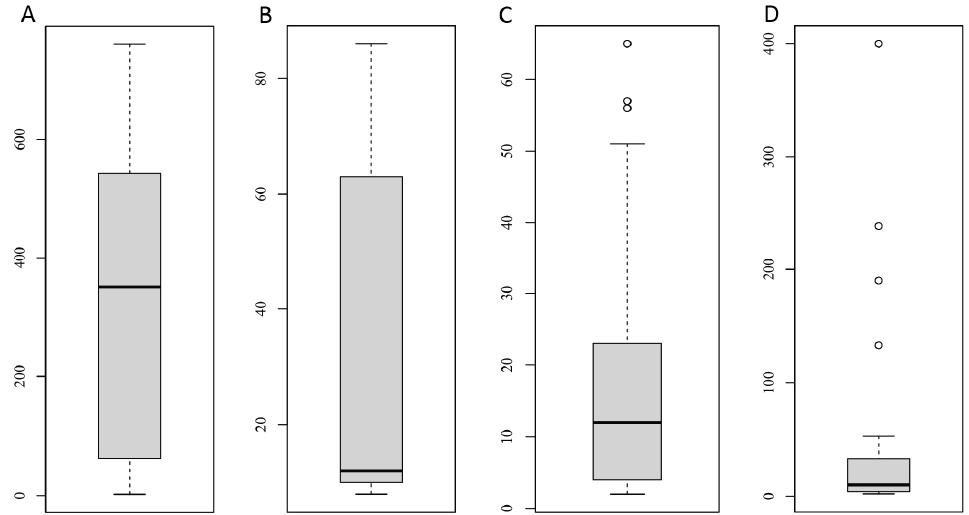
Figure 4. Egg count per gram of the observed helminth taxa in all samples. ( A ) Acanthocephala; ( B ) Capillariidae; ( C ) Trichostrongylidae; ( D ) Spiruroidea. Table 6. Details of the statistical analyses applied with EPG as response variable. Glm—generalized linear model; T—translocated;